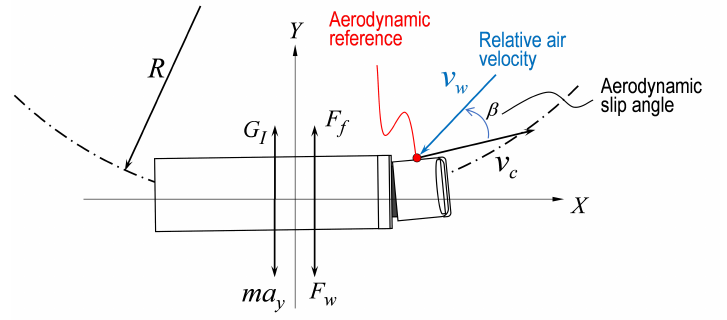
Figure 2. Tractor-trailer aerodynamic reference point and aerodynamic slip